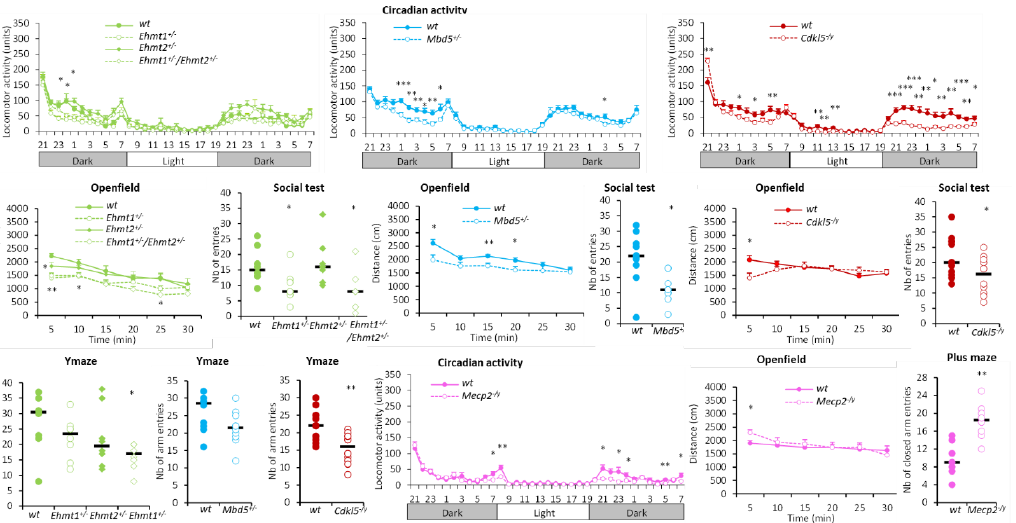
Figure 3. Hypoactivity group. Ehmt1 +/ − , Ehmt1 +/ − /Ehmt2 +/ − , Mbd5 +/ − and Cdkl5 − /y showed decreased activity in the circadian activity, in the open field, in social recognition and in the Y-maze tests, reflected by lower number of beam breaks, reduced distance, and lower number of visits or arm entries, respectively, as compared to wild-type counterparts. Mecp2 − /y showed decreased locomotion in circadian activity and increased closed arm entries in the elevated plus maze. Data are expressed as the mean ± SEM of front and back beam breaks (circadian activity) distance (open field) across time, or as scattergrams with the median for the number of entries (social, Y-maze, plus maze tests) and analysed using repeated measures ANOVA, followed by a t -test for each time point. * p < 0.05, ** p < 0.01, *** p < 0.001 vs. WT.